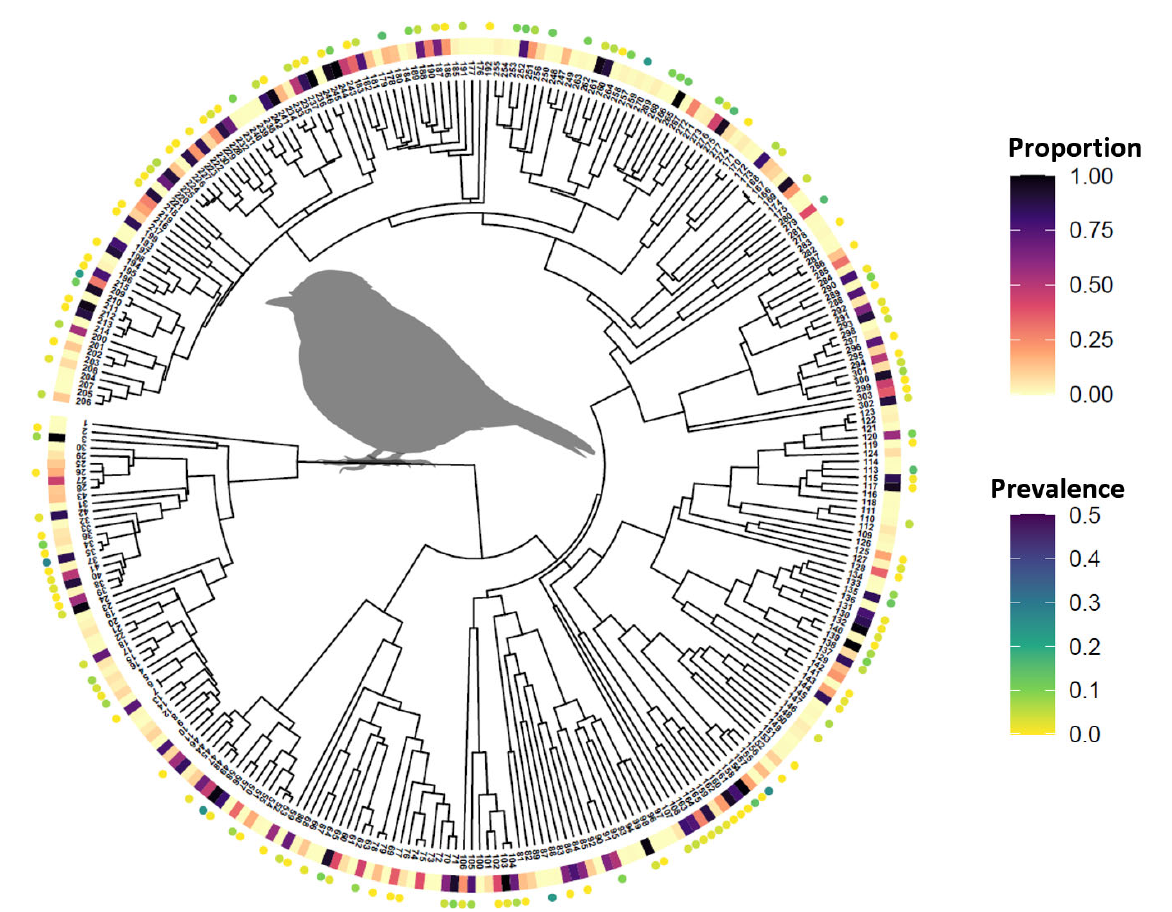
Figure 3. Phylogenetic tree for WNV avian hosts. Phylogenetic tree for 303 Passeriform species. Rectangular boxes near tree tips are color coded according to the legend at top right (Proportion) to indicate the proportion of US Counties where each species has been documented to occur. Rectangles coded as dark red indicate the species occurs in a high proportion of counties whereas lighter, yellow rectangles indicate relatively lower proportions. Circles surrounding tree tips correspond to legend at bottom right (Prevalence) and signify species-specific WNV molecular prevalence. Tree tips without circles indicate that prevalence information was not available at time of analysis. Figure A3 provided with Appendix A lists species names, proportion of occupied counties, and prevalence values for each tree